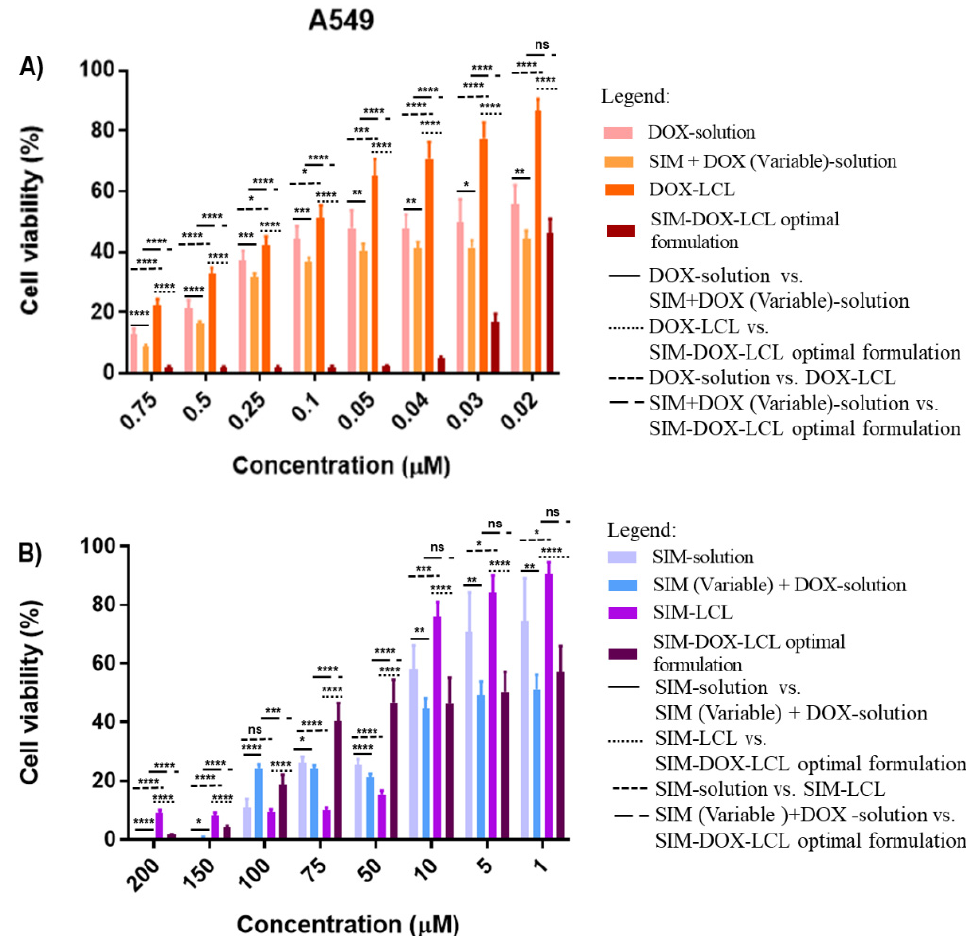
Figure 11. The effects of DOX ( A ) and SIM ( B ) treatments as monotherapy or in combination, on the proliferation of A549 human pulmonary cancer cell line. ns: not significant ( p -value > 0.05); * : p -value < 0.05; ** : p -value < 0.01; *** : p -value < 0.001; **** : p -value < 0.0001.